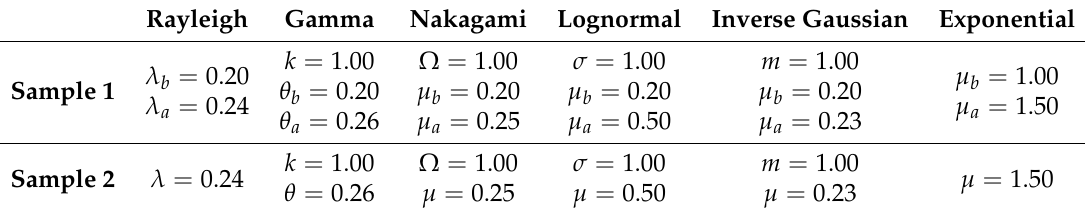
Table 2. Distributional parameters for case (iii) and (iv). λ , k , θ , Ω , m , u , and σ represent the scale, shape, scale, spread, shape parameters, log mean, and log standard deviation, respectively. Subscripts b and a indicate the parameters before and after the temporal change,